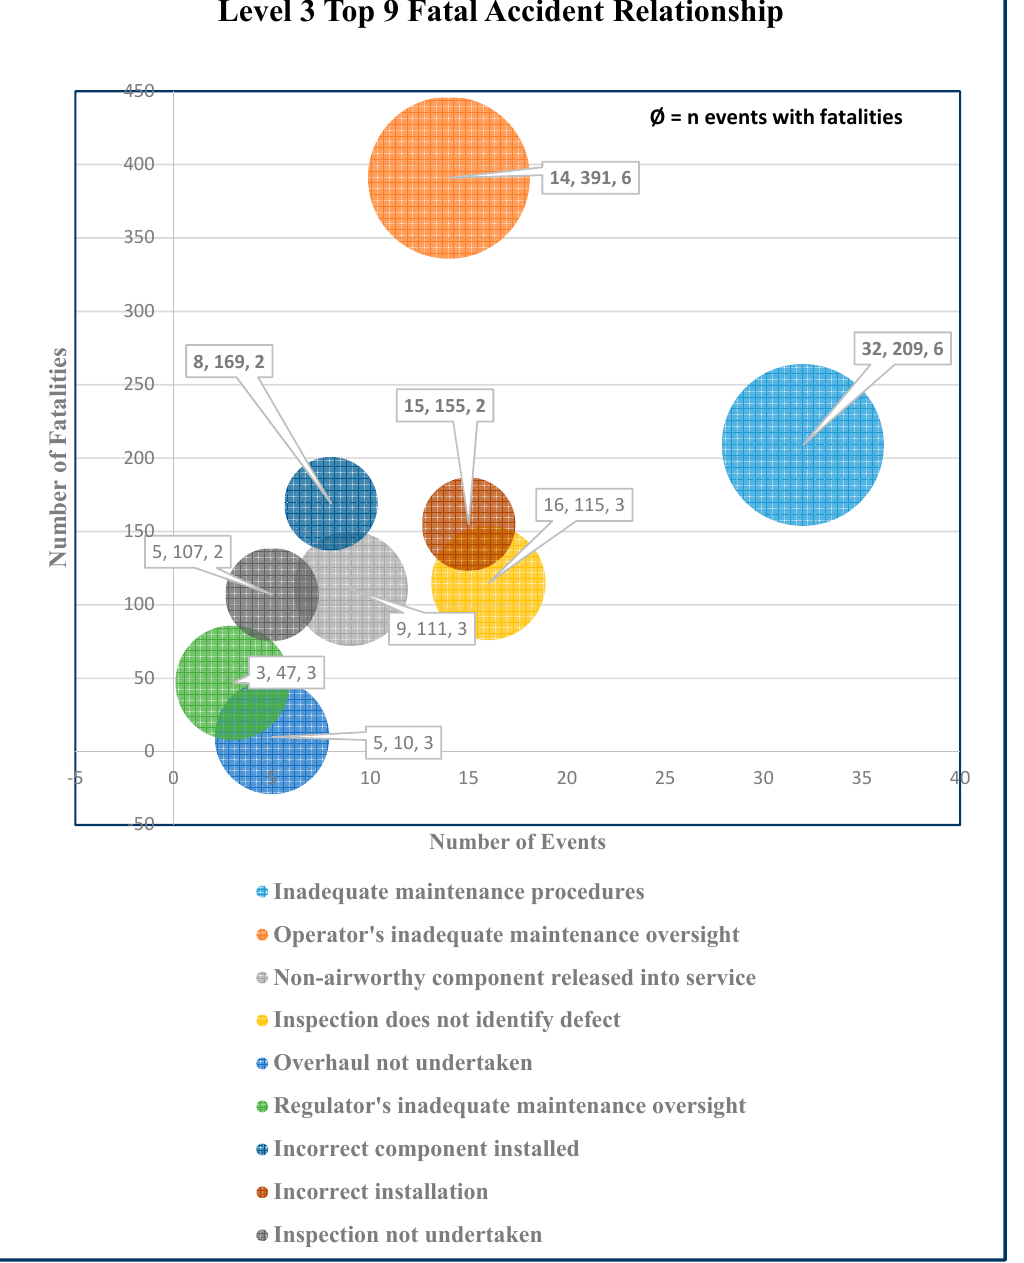
Figure 12. Level 3 fatal accident relationship.